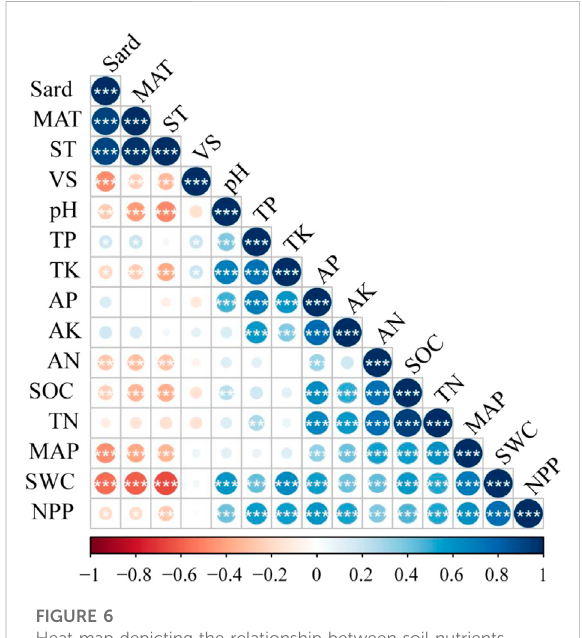
FIGURE 6 Heat map depicting the relationship between soil nutrients and environmental variables.